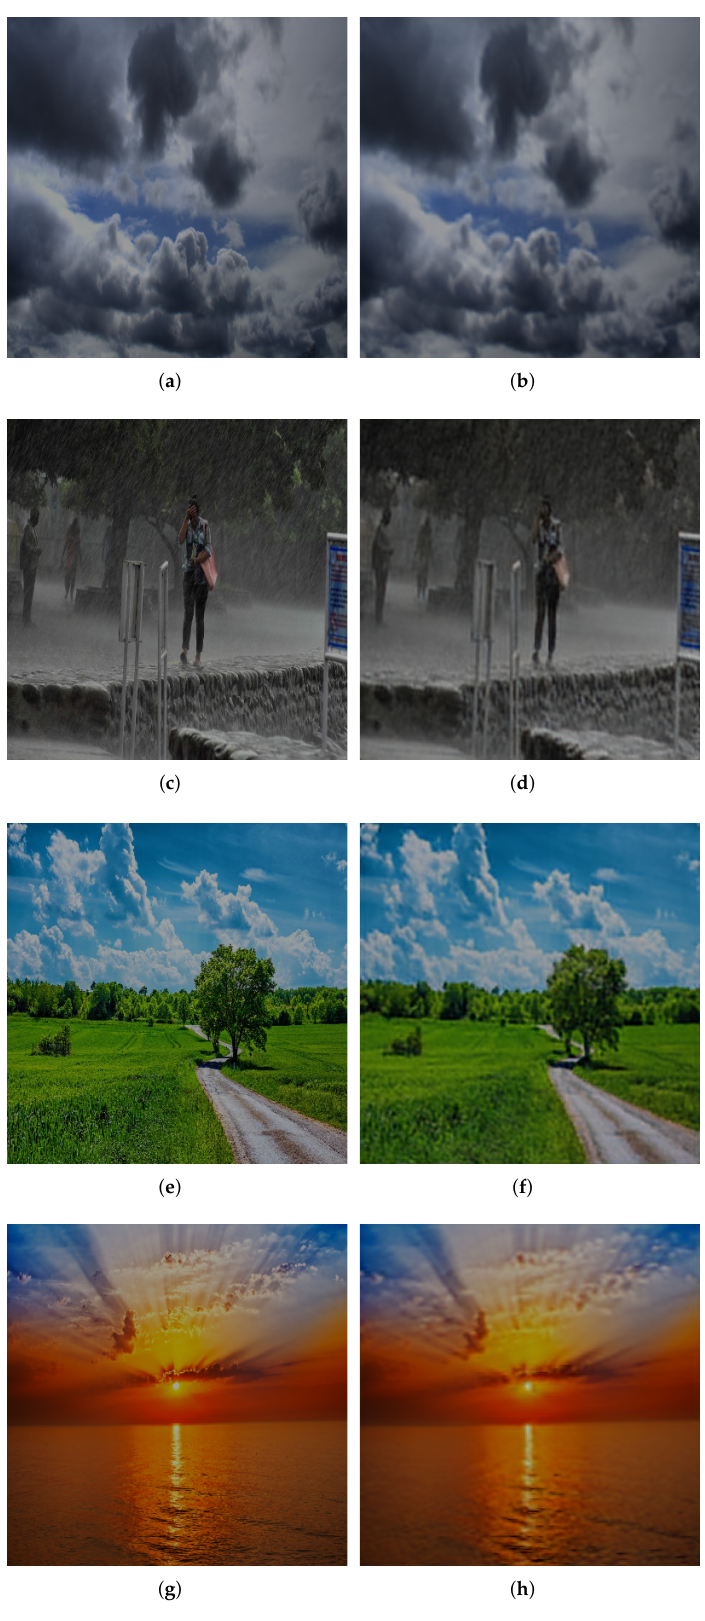
Figure 10. The original image and its compressed and reconstructed image. ( a ) Cloudy Original Image; ( b ) Cloudy Compression Reconstruction Image; ( c ) Rain Original Image; ( d ) Rain Compres- sion Reconstruction Image; ( e ) Shine Original Image; ( f ) Shine Compression Reconstruction Image; ( g ) Sunrise Original Image; ( h ) Sunrise Compression Reconstruction